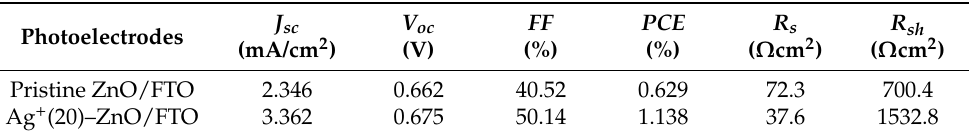
Table 4. Photovoltaic parameters of the champion cells with the pristine ZnO/FTO and Ag + (20)– ZnO/FTO